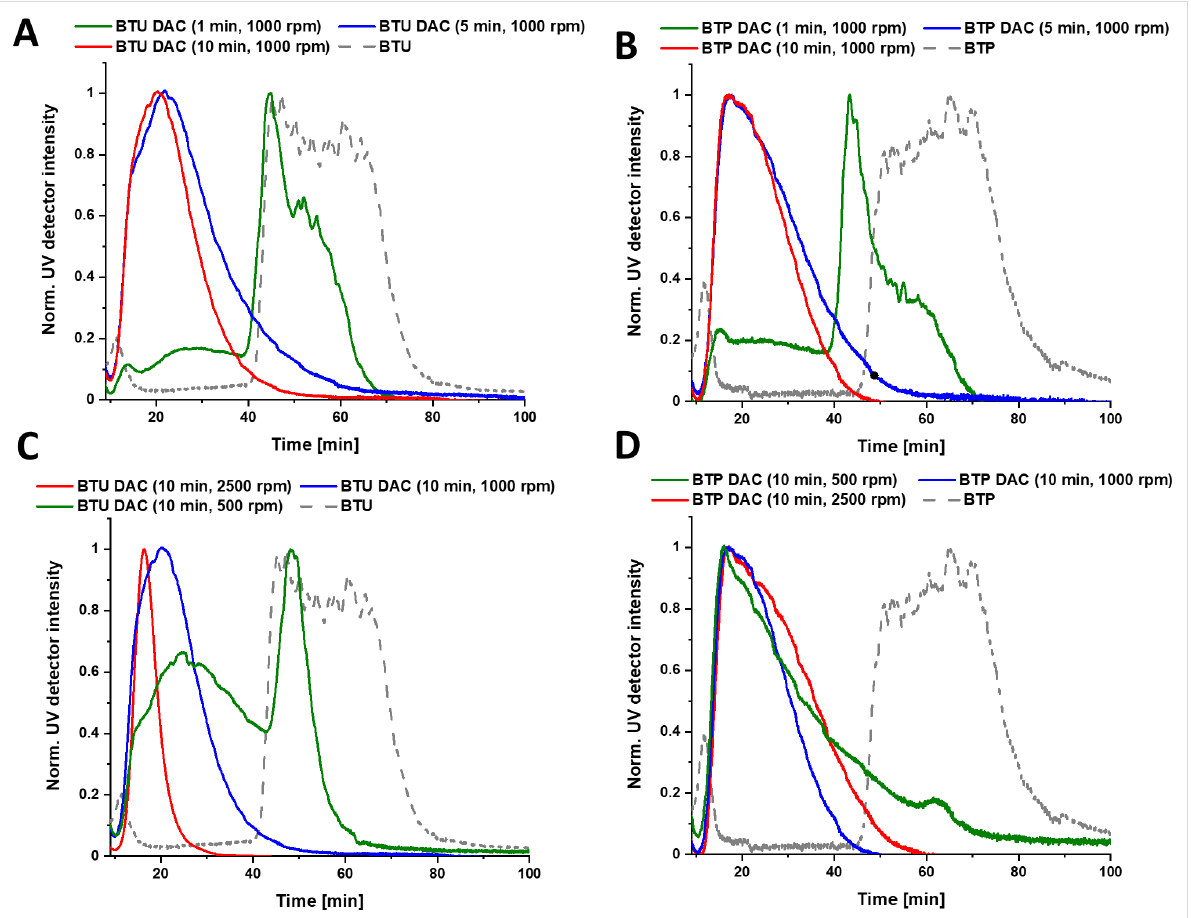
Figure 3: AF4 elution profiles showing the stability against dual centrifugation over different time ranges at a rotation speed of 1,000 rpm (A and B) and 2500 rpm (C and D) of BTU and BTP, respectively. Injection peaks are omitted for